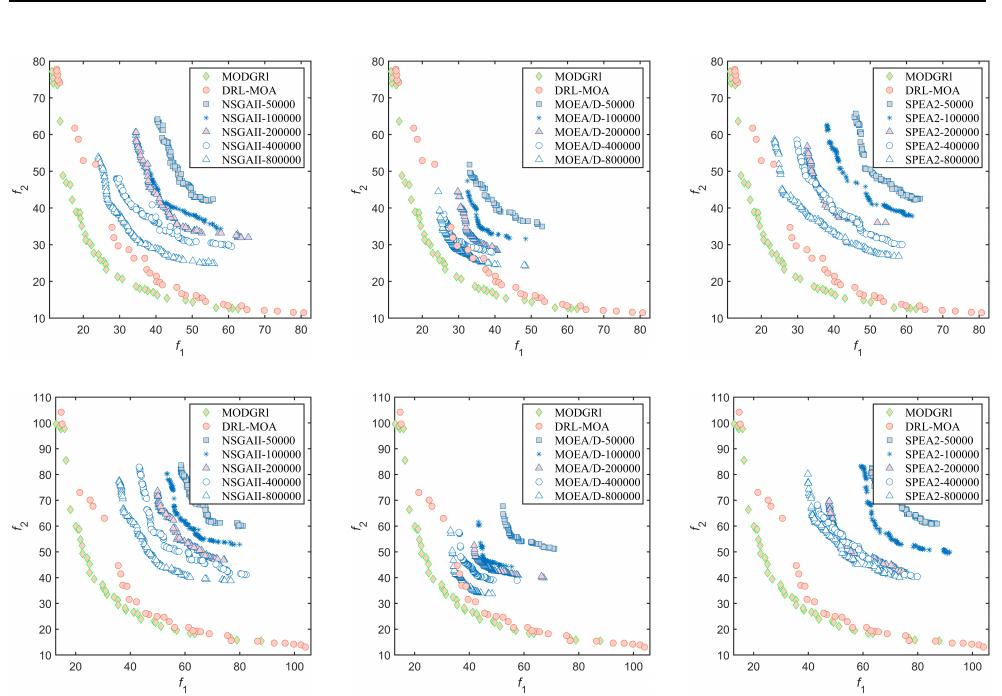
Figure A1. The Pareto-frontiers of 17 algorithms on the KroAB 150 dataset ( top row) and KroAB 200 dataset ( bottom